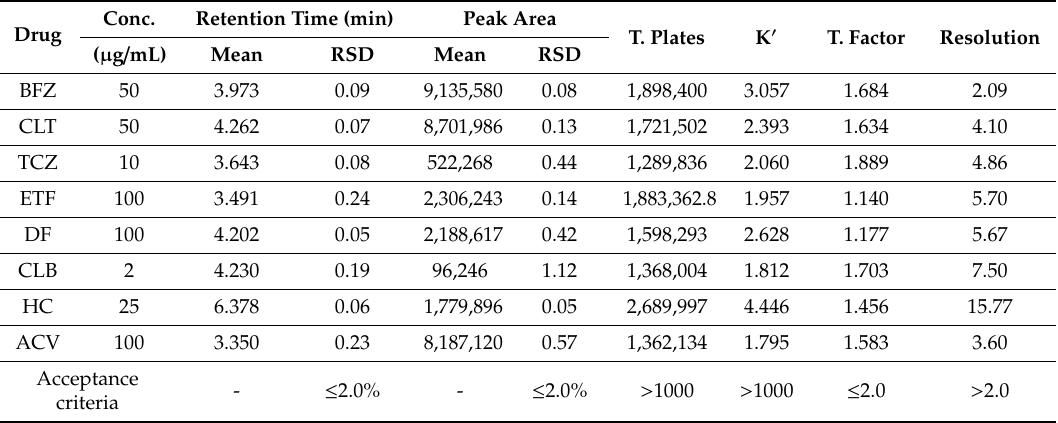
Table 5. System suitability test parameters. System suitability was evaluated by injecting the same standard solution six